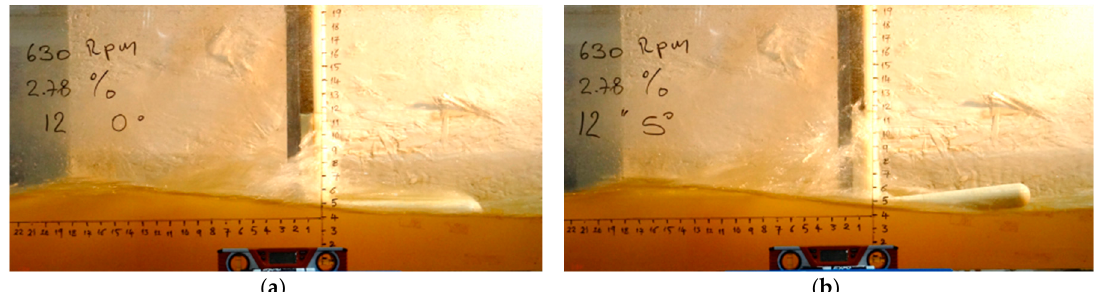
Figure 11. PWR for bulbs with different pitch angles.